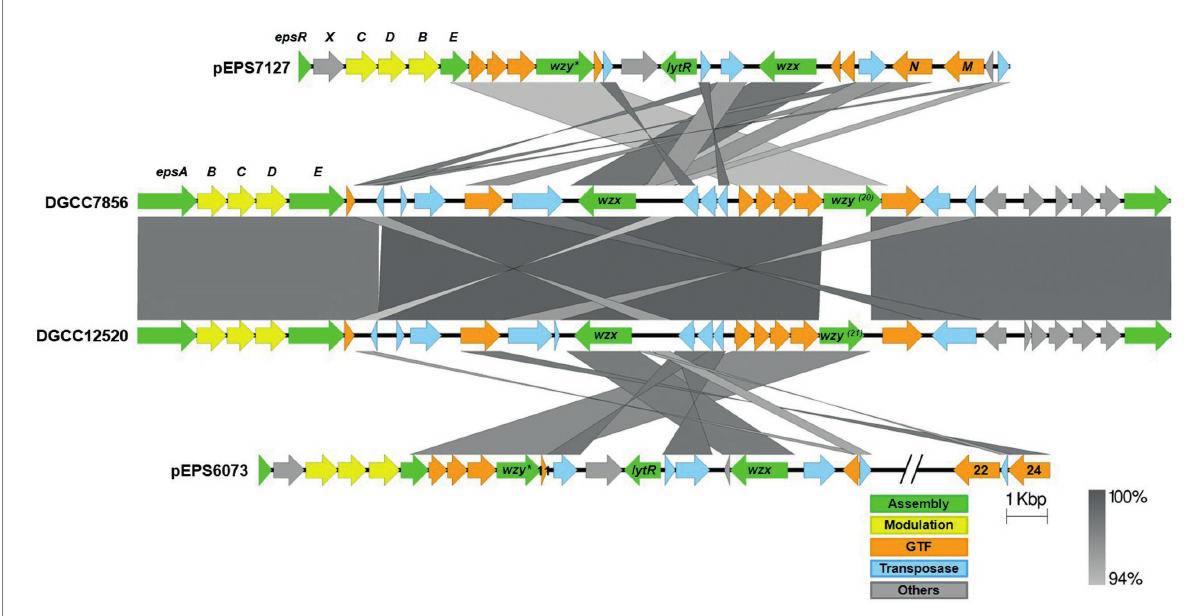
FIGURE 6 Alignment of streptococcal and lactococcal eps gene clusters. Comparison of lactococcal 6073-like and 7127-like eps gene clusters with related streptococcal clusters. Lactococcal 6073-like EPS is represented by pEPS6073, and 7127-like EPS is represented by pEPS7127. Numbers appearing over gene depictions correspond to locus tags as annotated in sequences submitted to GenBank. Genes are colored based on their putative function, including EPS assembly, EPS modulation, glycosyltransferase, transposase, or others. The putative polymerase ( wzy ), flippase ( wzx ), and attachment ( lytR ) genes are annotated as such. *indicates designated signature genes. Gray bars are used to indicate sequence